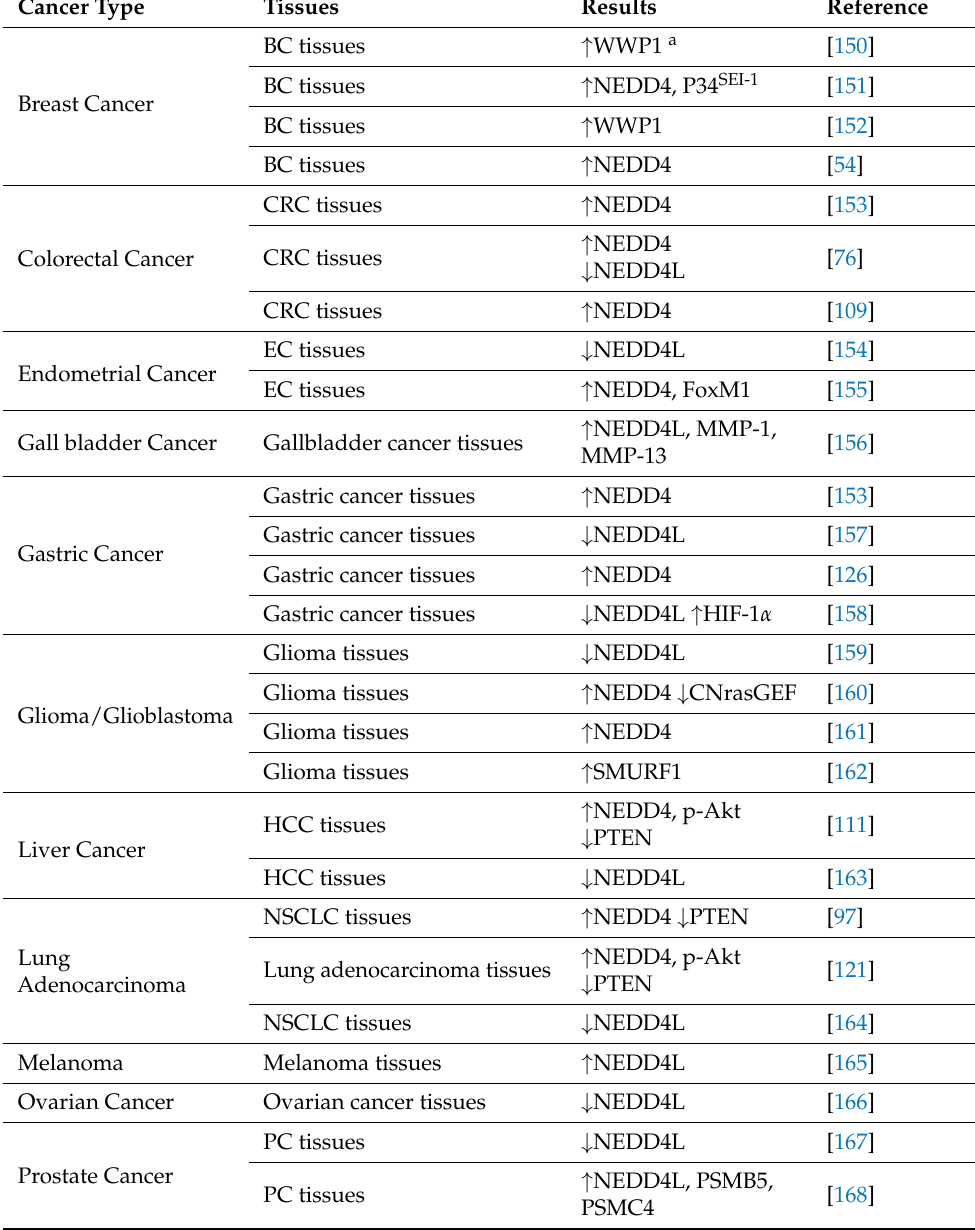
Table 1. Regulation of NEDD4-like E3 ligases in various cancers in clinical